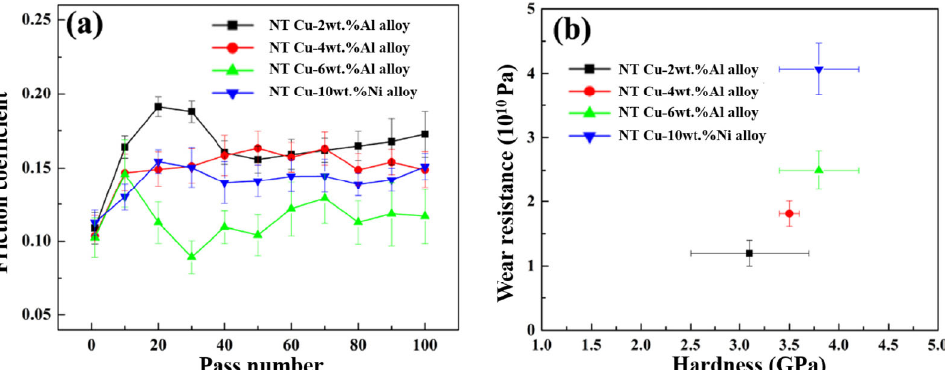
Fig. 2 (a) Friction coefficient as a function of sliding pass number for different NT Cu alloys and (b) comparison of wear resistance and hardness for NT Cu